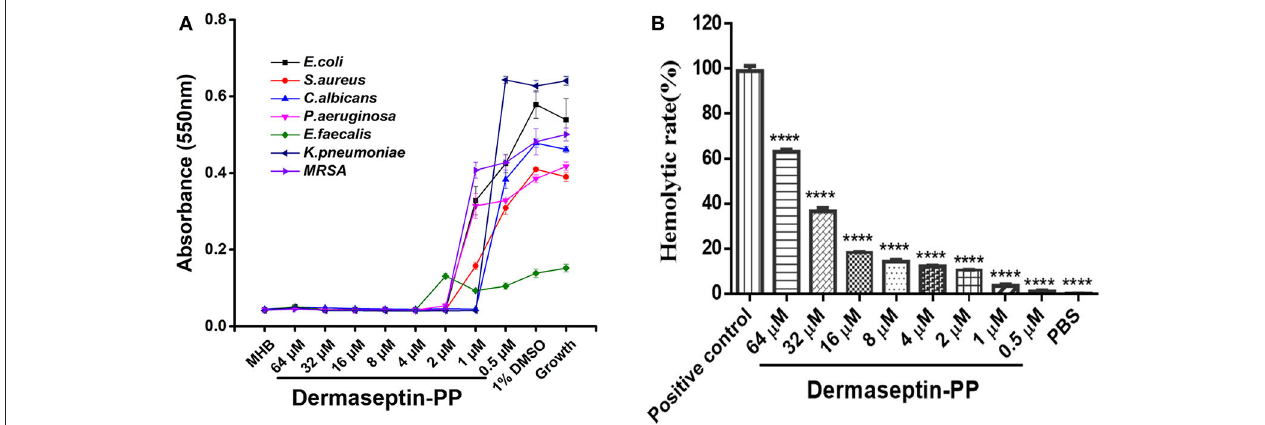
FIGURE 2 | (A) The antimicrobial activity of Dermaseptin-PP against the growth of E. coli , S. aureus , C. albicans , P. aeruginosa , E. faecalis , K. pneumoniae, and MRSA . The data represents means ± SEM (standard error of the mean) of three independent experiments. MHB is blank control; 1% DMSO is vehicle control; Growth represents the growth control (normally growing microorganism in MHB). The Y-axis represents absorbance, higher absorbance refers to more visible microorganisms, indicating lower antimicrobial activity. (B) The hemolytic activity of Dermaseptin-PP (at concentration from 0.5 to 64 µ M) on horse erythrocytes. Values are the mean ± SEM for three independent experiments. The significance of group difference was determined by Dunnett’s multiple comparisons of one-way ANOVA in GraphPad Prism (version 6.0) software. **** P < 0.0001 vs. positive control (2% Triton X-100).